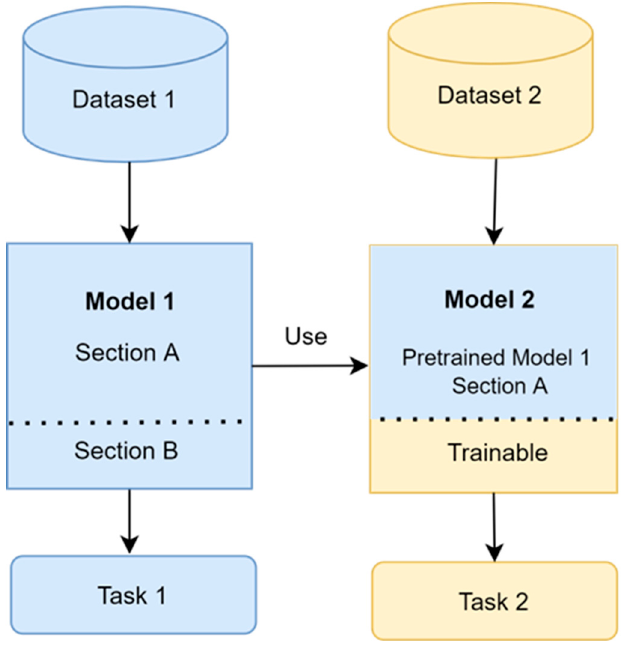
Figure 12. Transfer Learning.